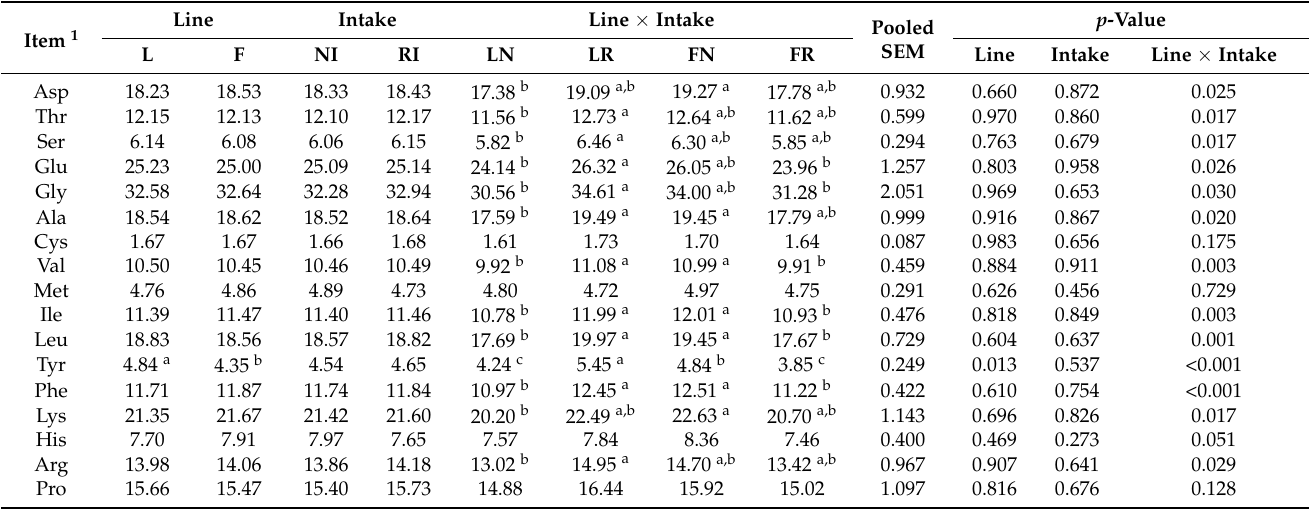
Table 7. Effect of feed intake on amino acids contents of 56-day-old offspring thigh muscle in broiler hens during laying period (n =